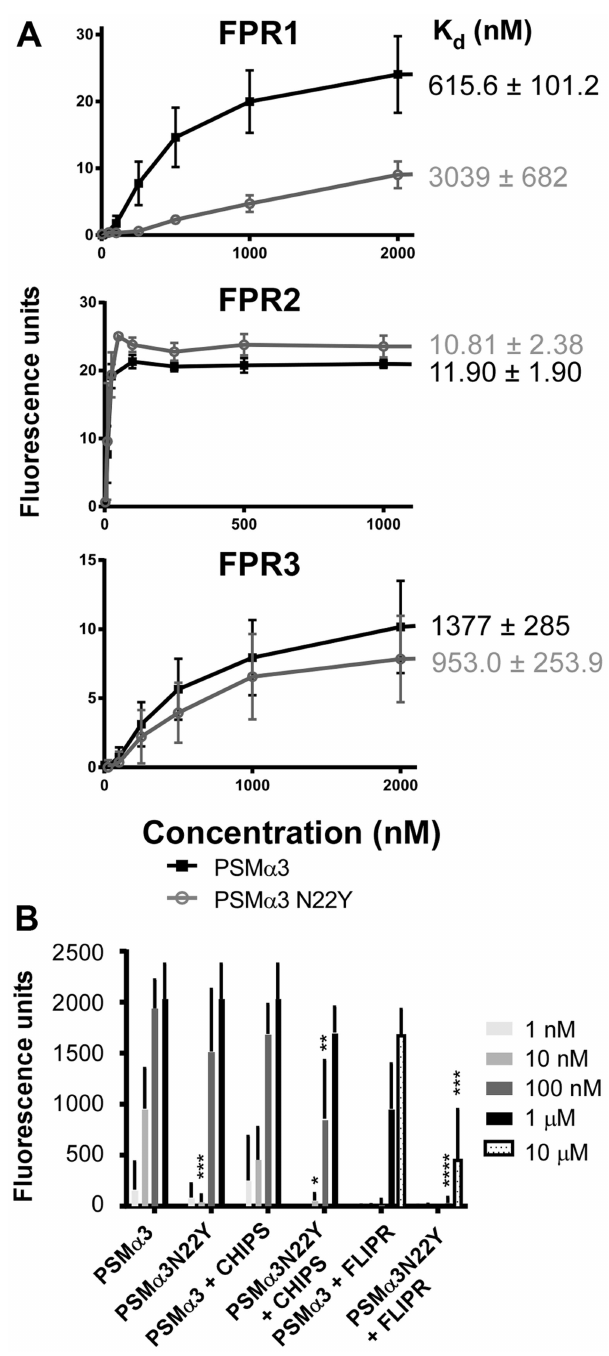
Figure 4. PSM a 3N22Y shows decreased activation of FPR1. (A) Differential activation of FPRs by PSM a 3 versus PSM a 3N22Y was measured using synthetic peptides and Ca 2 + flux observed in HL60 cells stably transfected with the corresponding FPR genes as readout, using three biological and two technical replicates. The calculated K d values are shown on the right. The obtained curves were significantly different for PSM a 3 versus PSM a 3N22Y only in the case of FPR1. (B) Ca 2 + flux in human neutrophils upon addition of PSM a 3 or PSM a 3N22Y and inhibition by FLIPr (FPR2 inhibitor) or CHIPS (FPR1 inhibitor). Neutrophils were from three donors and the measurements were performed in quadruplicate. *, p , 0.05; **, p , 0.01; ***, p , 0.001; ****, p , 0.0001 (comparing values obtained with PSM a 3 versus correspond- ing values obtained with PSM a 3N22Y).